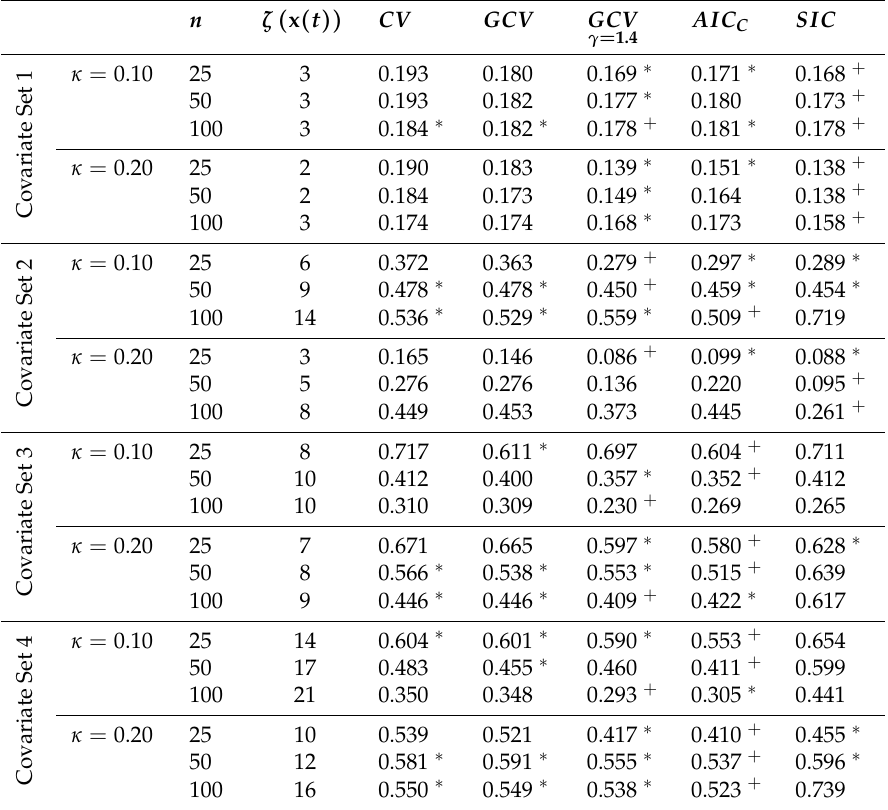
Table 1. The SMK under each smoothing parameter selection criterion for each simulation setting under parameter curve β 1 ( t ) . A + next to a SMK for a given sample size indicates the lowest SMK across the different smoothing parameter selection methods. A ∗ next to an SMK for a given sample size indicates that the SMK was not significantly different from lowest SMK